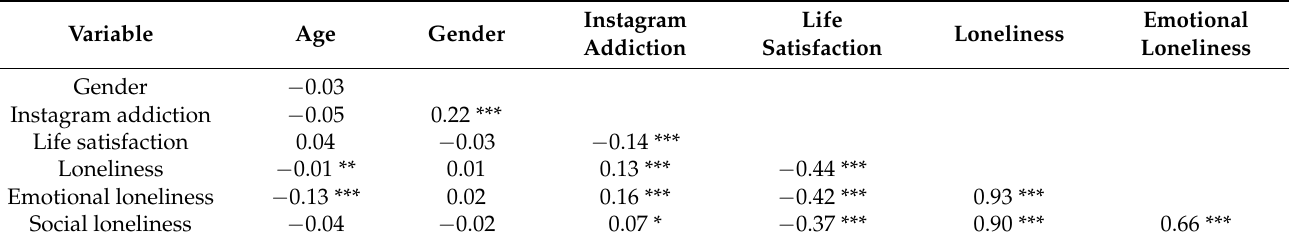
Table 2. Spearman’s correlations ( N =